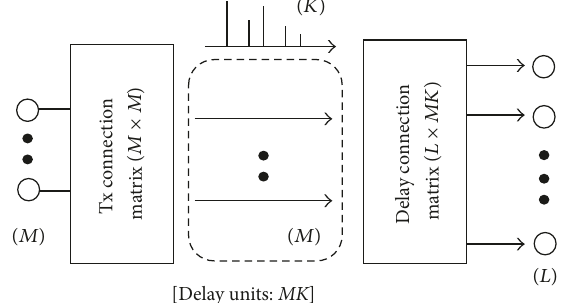
Figure 5: Advanced antenna-branch-controlled